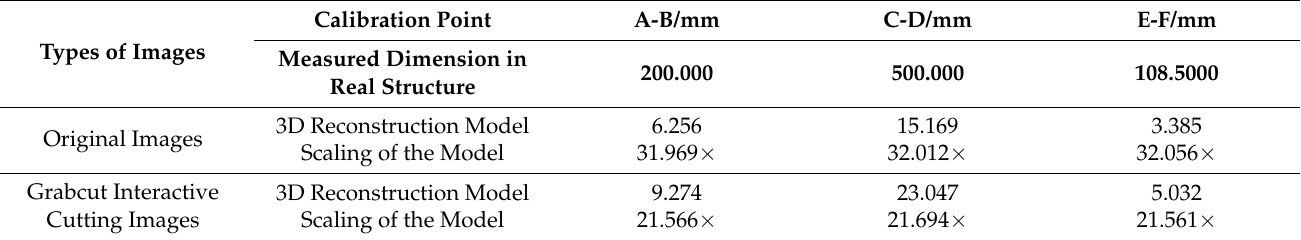
Table 2. The size conversion relationship between the 3D reconstruction model and the actual structure.